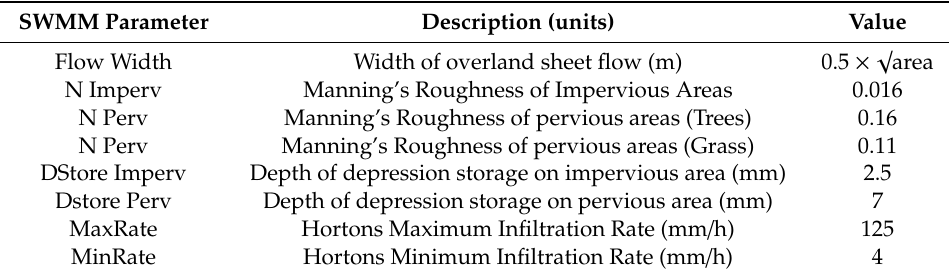
Figure 3. Subsurface and open channel hydraulics represented in SWMM model. Table 3. SWMM model hydrologic parameters.